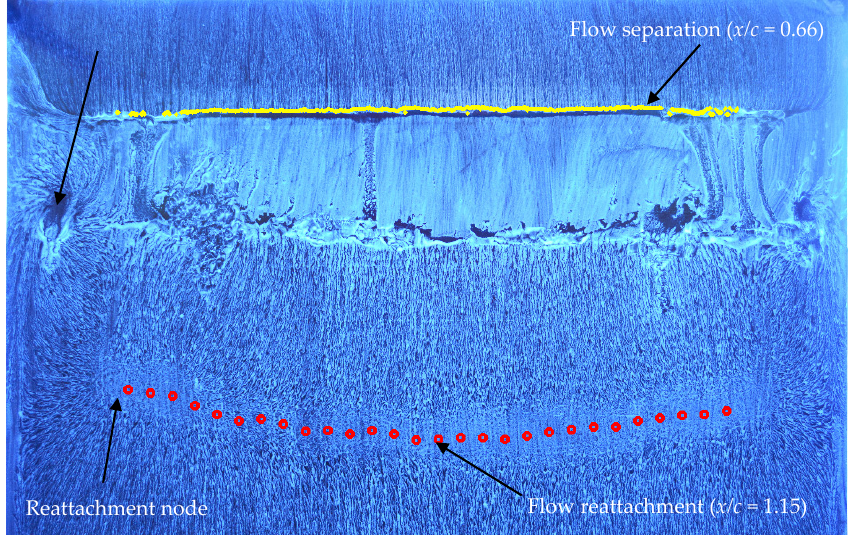
Figure 4. Surface oilflow visualization of the baseline flow.